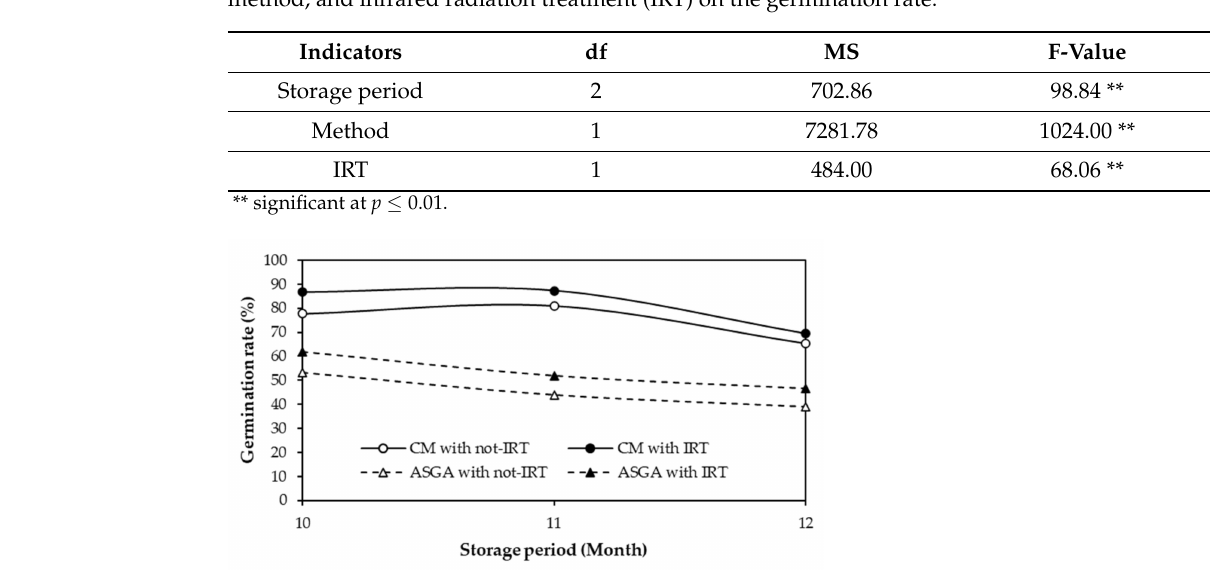
Table 3. Statistical analysis with ANOVA for the effects of the storage period (months), soaking method, and infrared radiation treatment (IRT) on the germination rate.